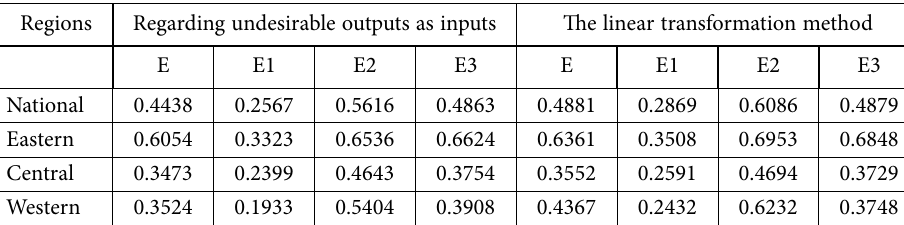
Table 3. The environmental efficiencies of different models